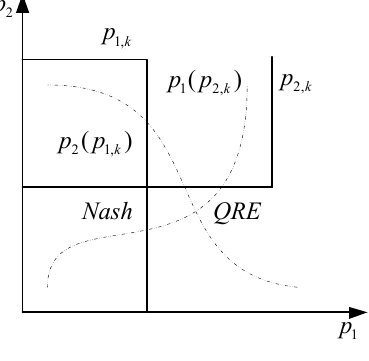
Figure 1. Nash equilibrium and QRE.